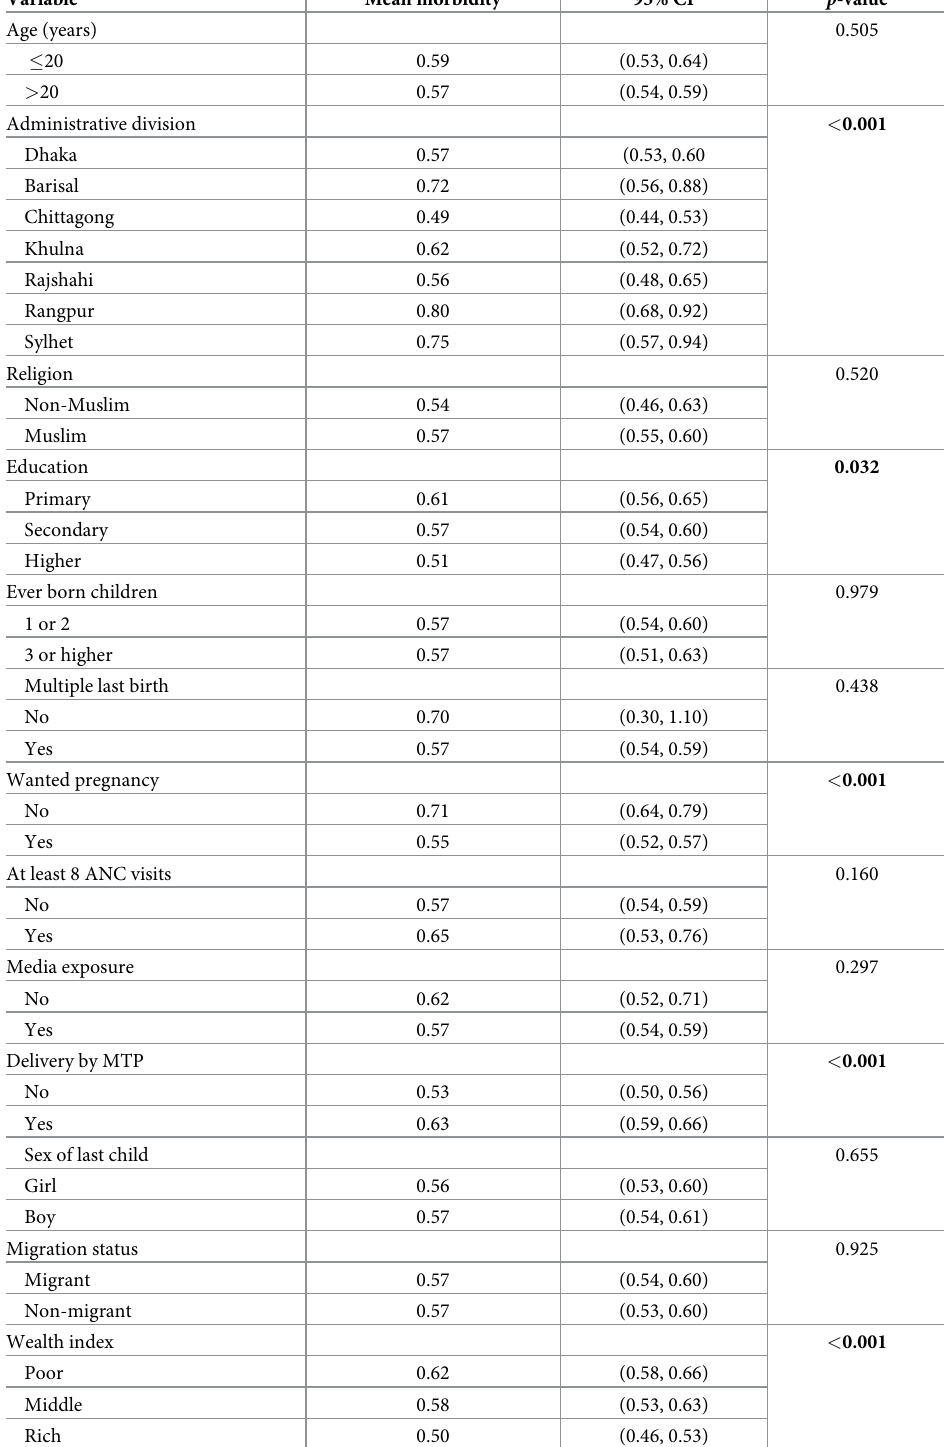
Table 3. Bivariate analysis of the socio-economic and demographic variables along with 95% confidence interval (CI) for mean number of pregnancy complications along with p -values of the ANOVA F